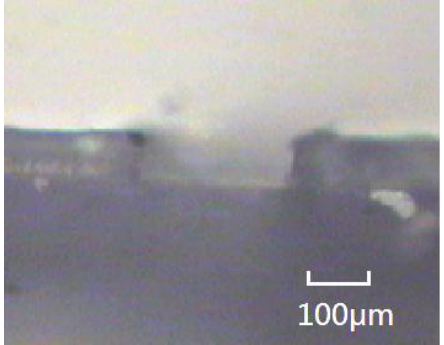
Figure 11. Cross-section of a rectangle